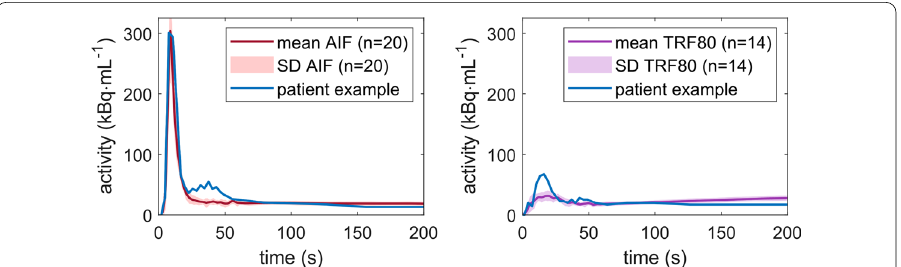
Fig. 7 Time activity curve comparison of average phantom data ( [33]). AIF arterial input function, TRF80 tissue response function at a volume flux of 80